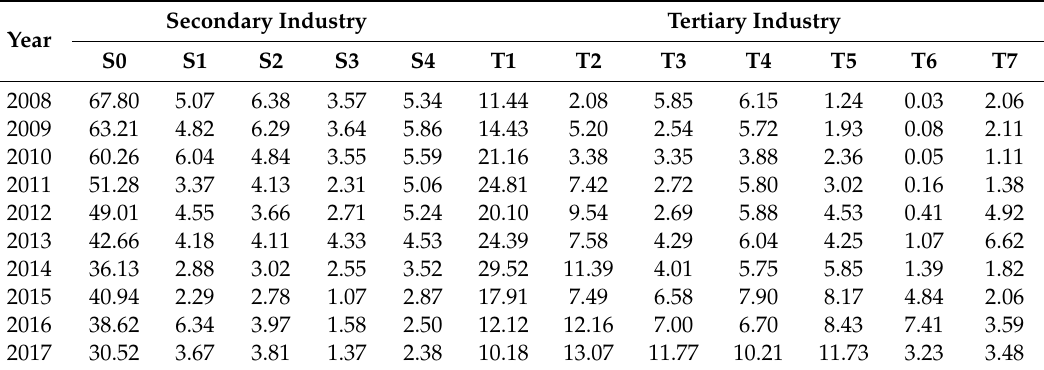
Table 2. Sector structure of FDI in Zhejiang Province (2008 to 2017)